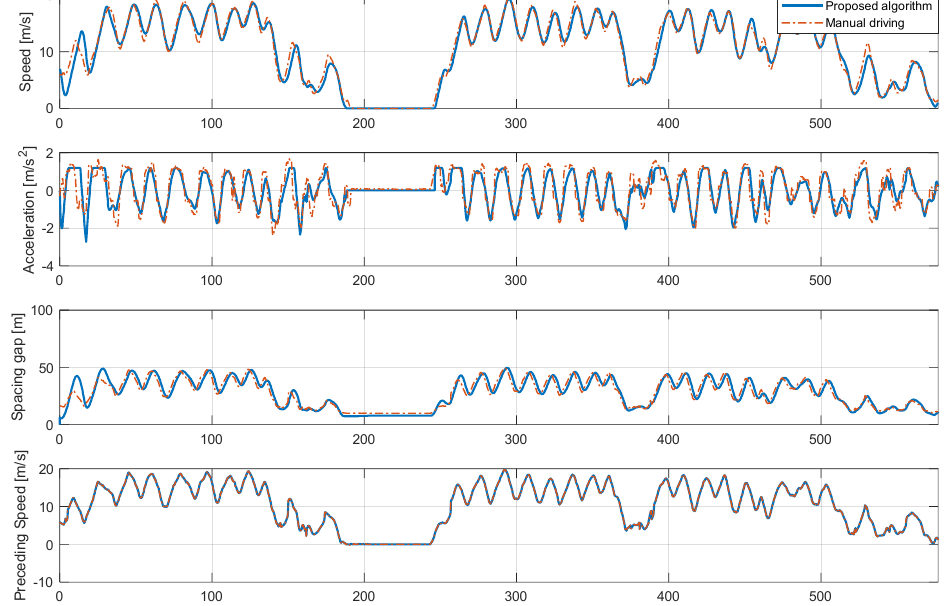
Figure 12. Driving simulation results of the proposed algorithm of 2nd driver for the entire route.